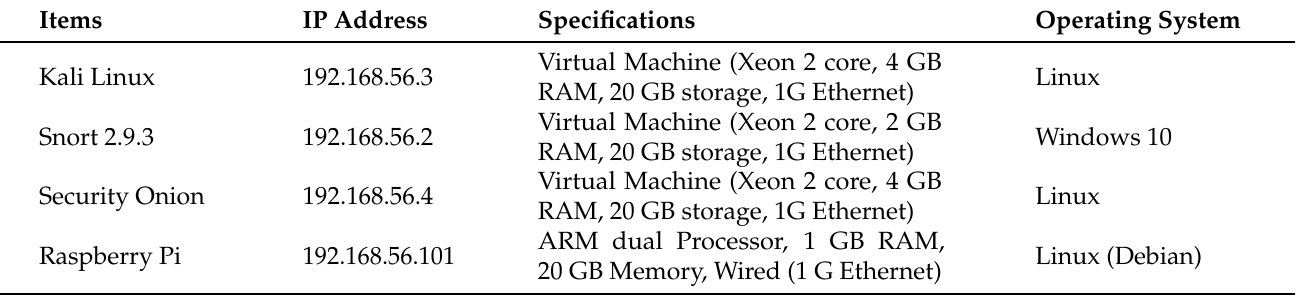
Table 2. Configuration parameters of the experiment.